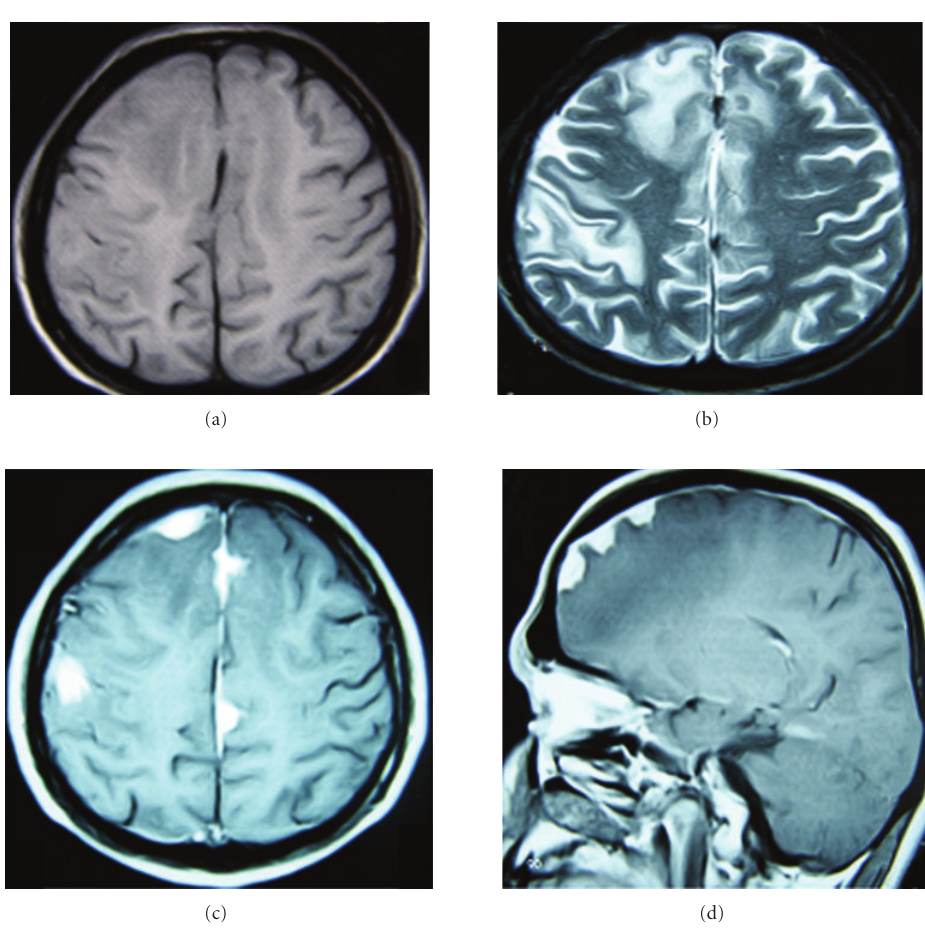
Figure 1: Cranial magnetic resonance imaging (MRI) shows multiple dural-based enhancing lesions on unenhanced (a) and enhanced T1-weighted axial (c) and sagittal (d) images with cerebral edema on T2-weighted images (b).